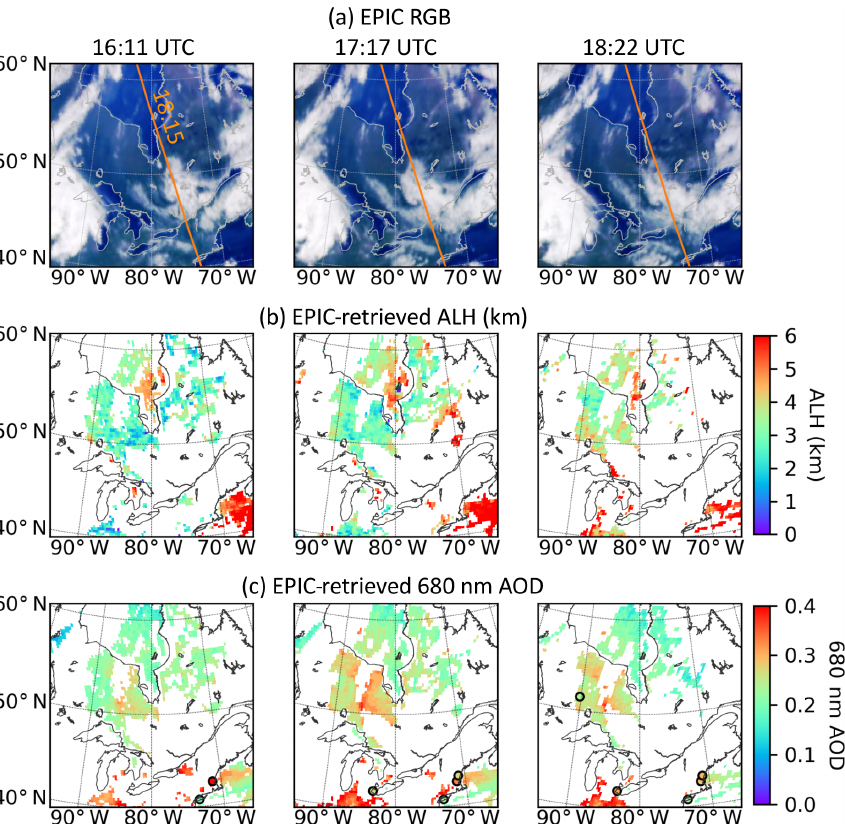
Figure 8. Same as Fig. 7 but for three EPIC scenes captured on 26 August 2017 at UTC times of 16:11, 17:17, and 18:22. The CALIOP overpass was at 18:15UTC.